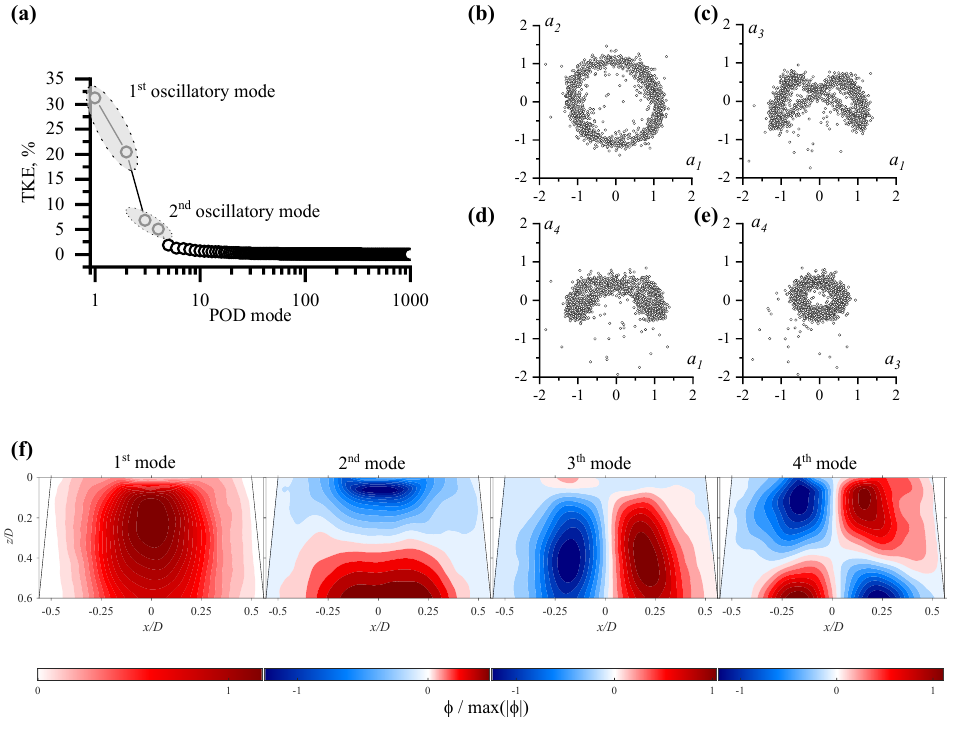
Figure 5. POD analysis for 0.5 Q c : TKE content of POD modes ( a ), Lissajous figures of a 1 − 4 ( b – e ), and the POD mode shapes ( f